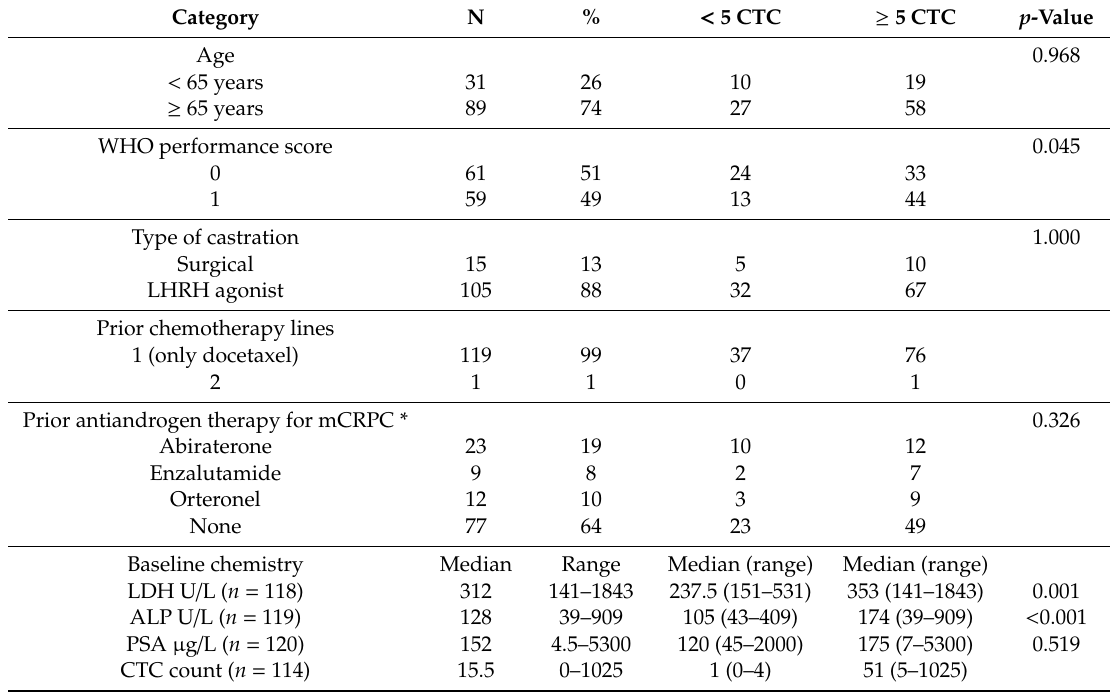
Table 1. Patient characteristics.